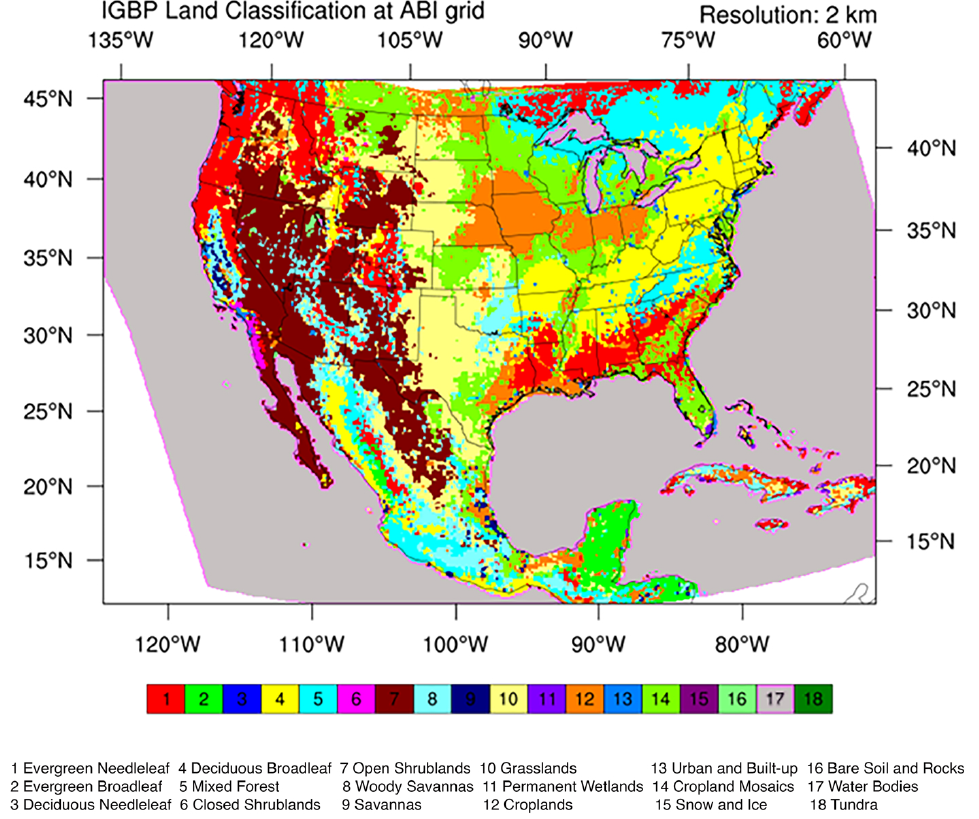
Figure 5. Re-mapped IGBP surface classifications over CONUS on the 2km ABI